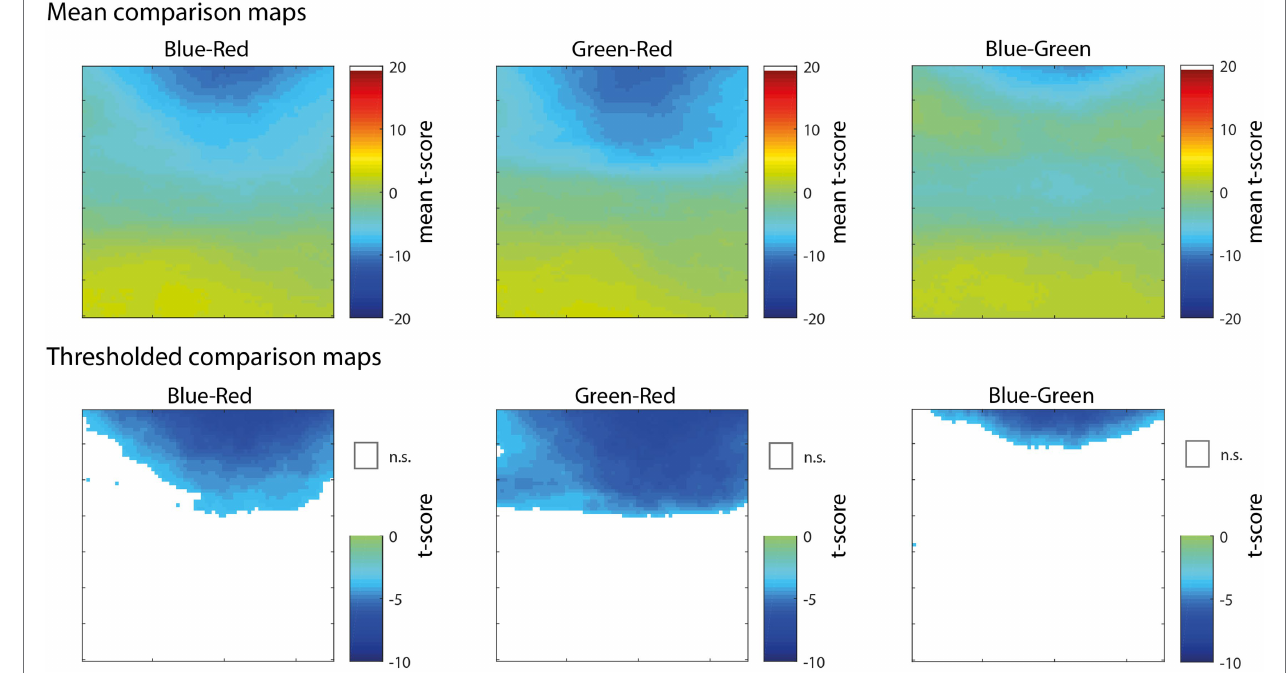
FIGURE 4 | Maps showing pixel-wise t -scores (top row) for the comparison of correlations for dependent samples, comparing blue-red channel (left), green-red channel (middle), and blue-green (right). Thresholded versions of the same maps (bottom row) showing significant pixels (FDR < 0.01) colored by t -score according to the color map and non-significant pixels represented as